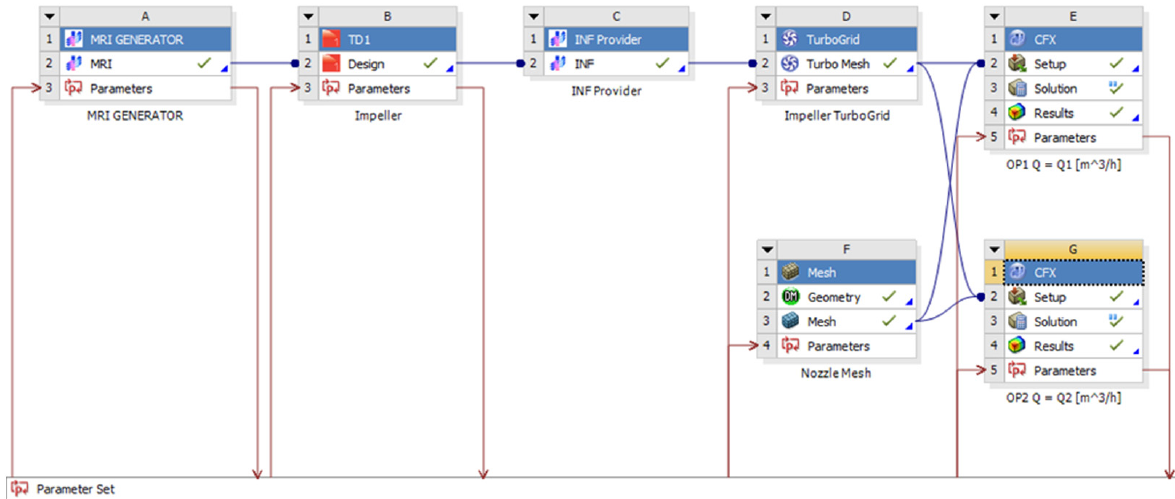
Figure 9. Automated DOE workflow in ANSYS Workbench.